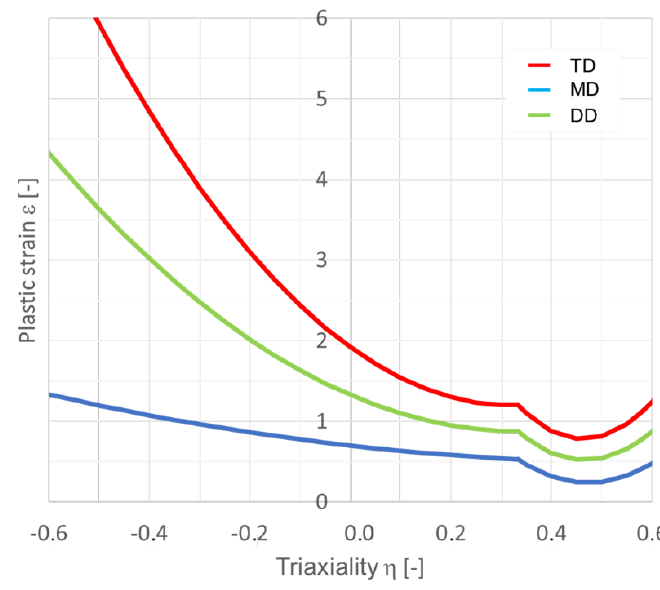
Figure 12. Failure curves vs. triaxiality for 0 ◦ (blue), 45 ◦ (green) and 90 ◦ (red) of orthotropy.